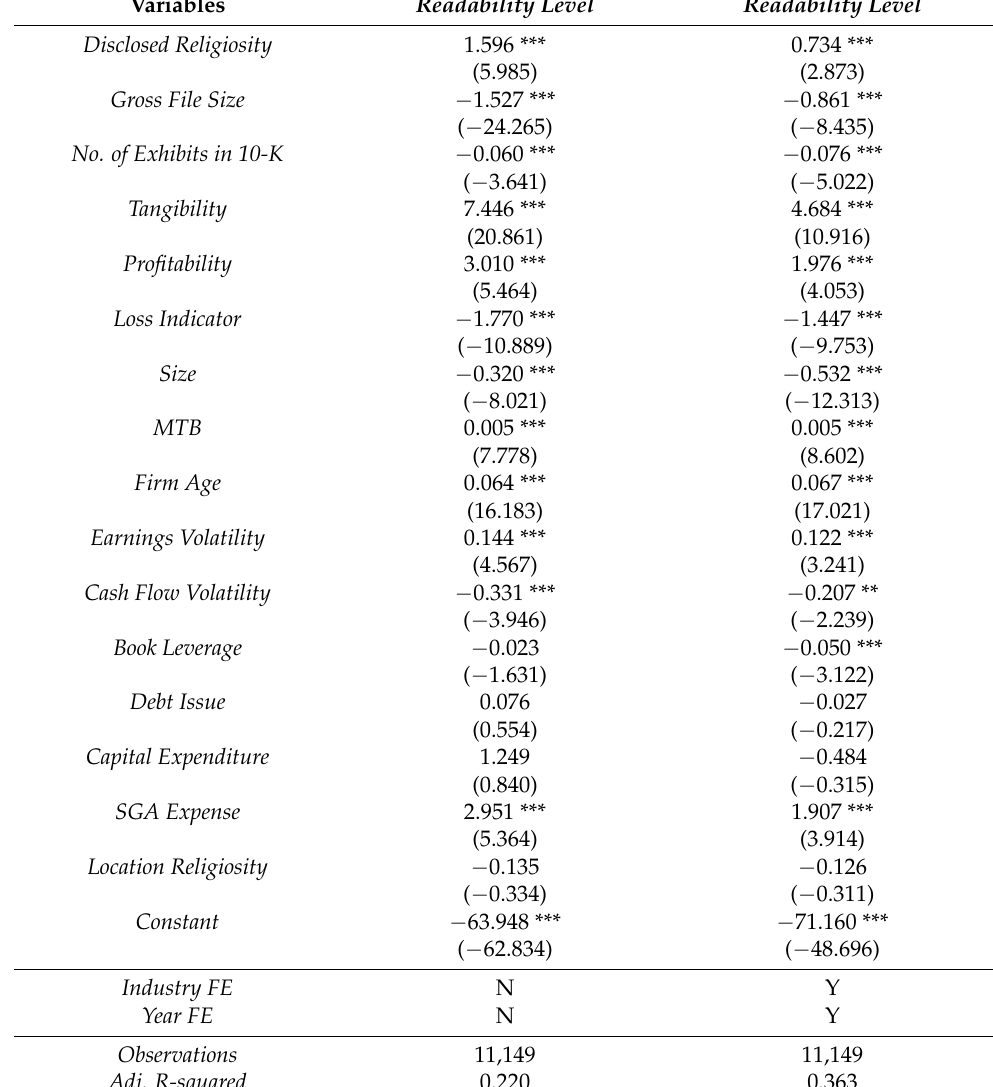
Table 3. Impact of CEO Religiosity on Annual Report Readability.